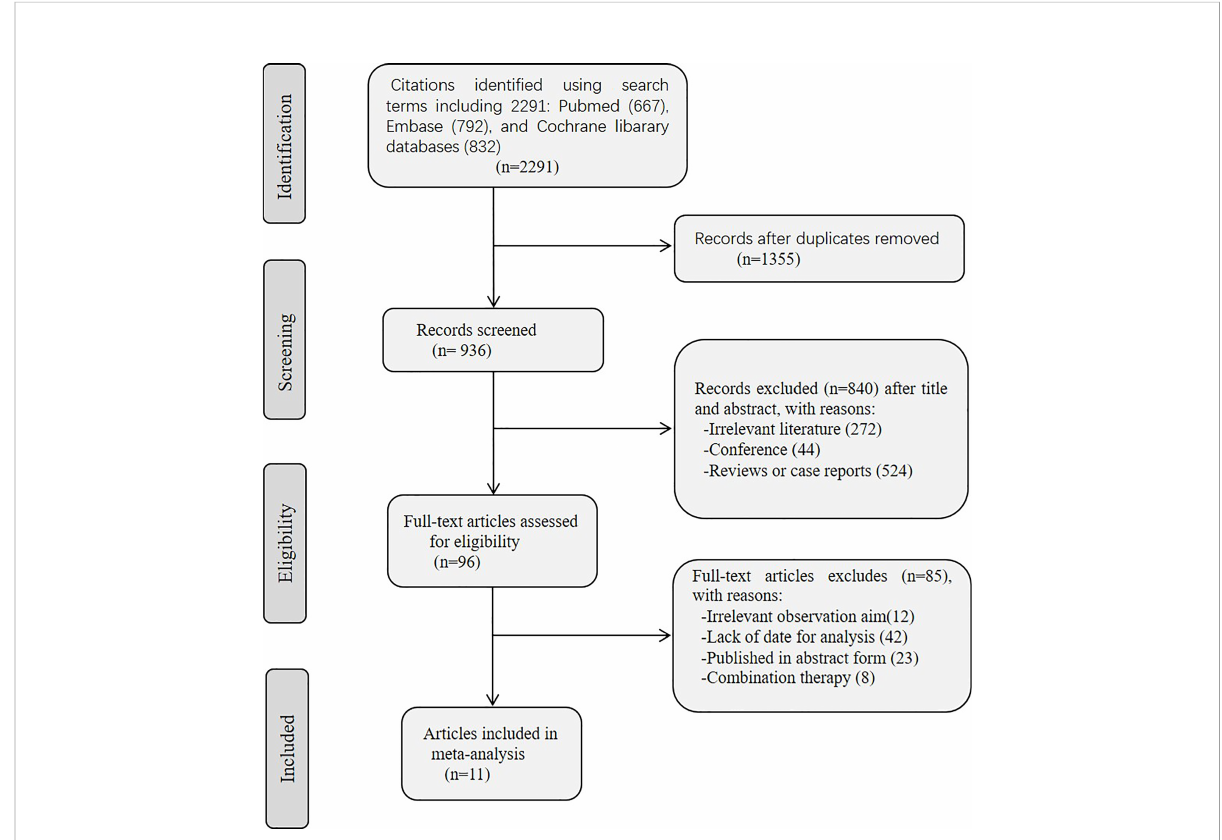
FIGURE 1 Flow diagram of study selection process for this systematic review and